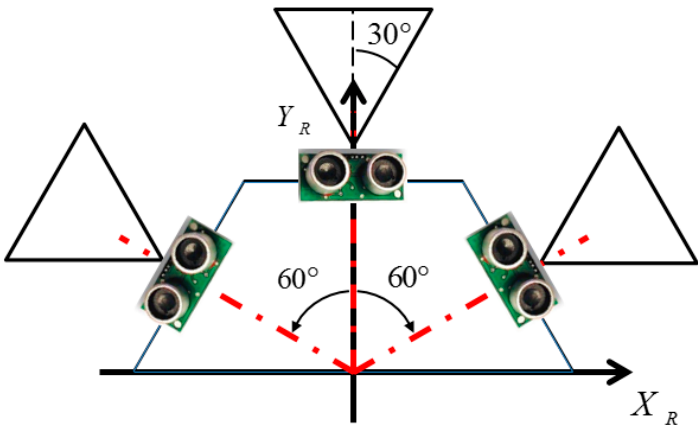
Figure 10. Configuration of the ultrasonic sensors on the mobile